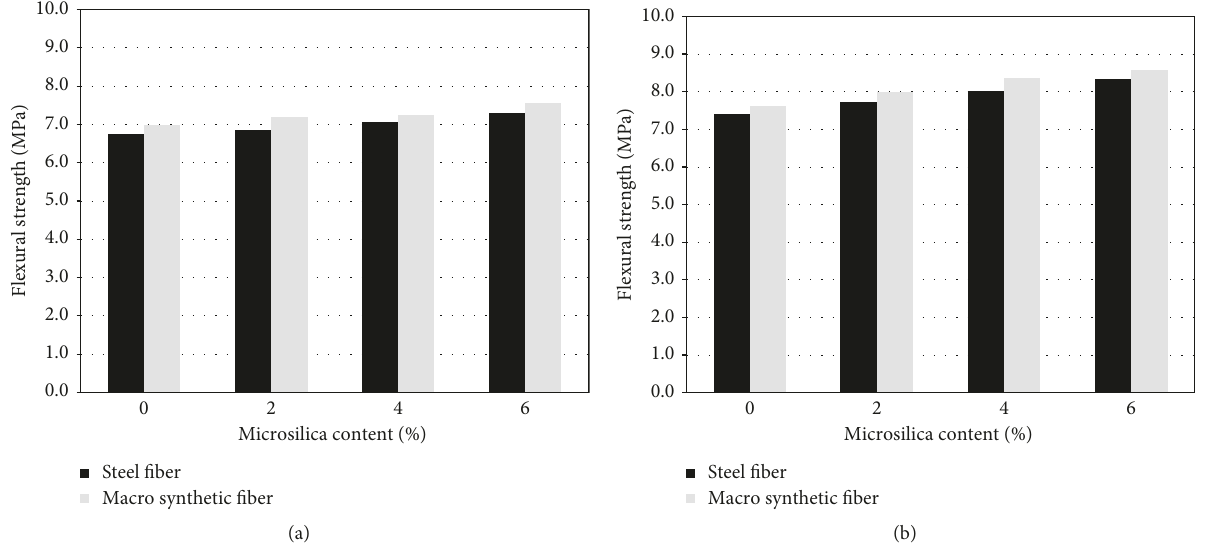
Figure 3: Flexural strength by microsilica content. Target strength of (a) 40MPa and (b)